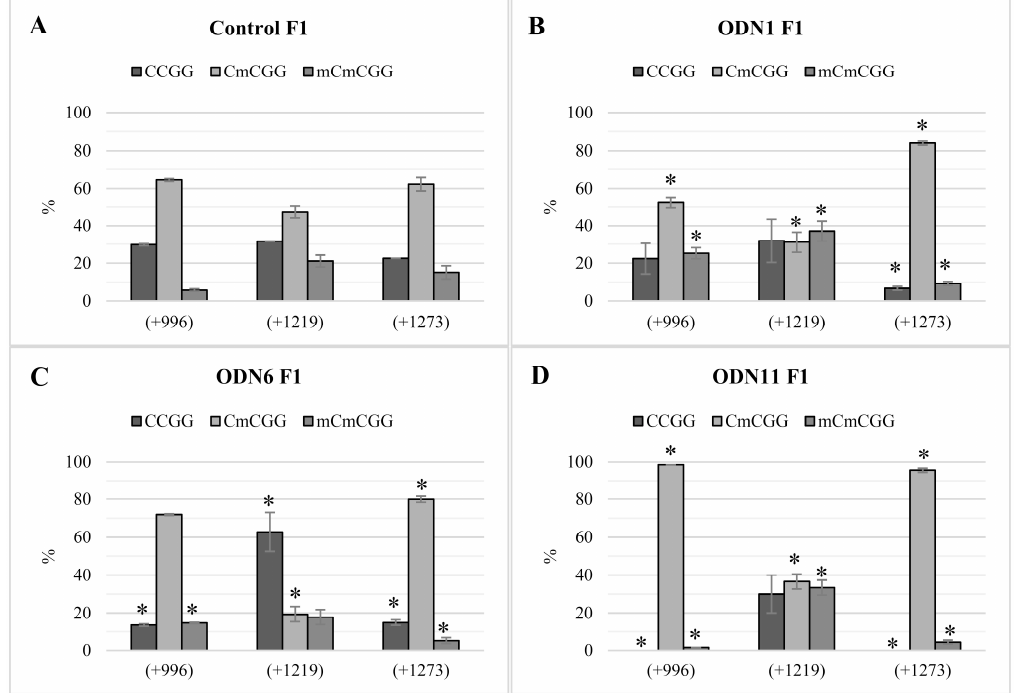
Figure 2. Methylation in the variable CCGG motifs identified in the CHS gene sequence in the F1 generation of control plants ( A ) and individuals that maintained modifications induced by ODNs ( B – D ), cultivated in the experimental field. The seeds obtained from F0 plants were sown and plants were cultivated in the field. The figure presents the percentage of cytosine methylation in the variable CCGG sites ( + 996, + 1219, + 1273) located in the coding region of the CHS gene sequences. The genomic DNA was digested by restriction enzymes HpaII and MspI. The amount of non-digested DNA was determined by real-time PCR. The percentage of a particular modification is presented for studied plants and control: CCGG—lack of methylation (dark grey), CCmGG—methylation of internal cytosine (light grey) and CmCmGG—methylation of both cytosines (medium grey). The site positions were presented according to the LuCHS6 sequence, due to the presence of all CCGG sites. Data represent the mean value ± SD from at least three independent + experimental repeats. The significance of the di ff erences between each mean and control was determined by Student’s t -test. Asterisk indicates * p < 0.05.